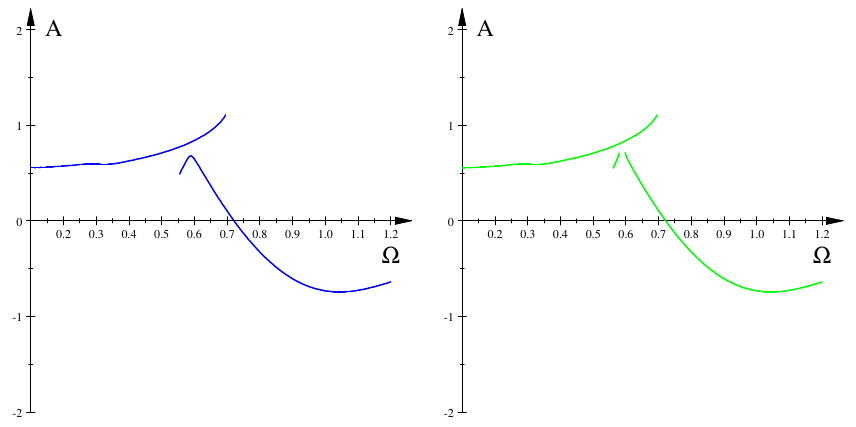
Figure 5. Bifurcation diagrams: h = 0.3264, f = 0.5206—left, h = 0.3264, f =